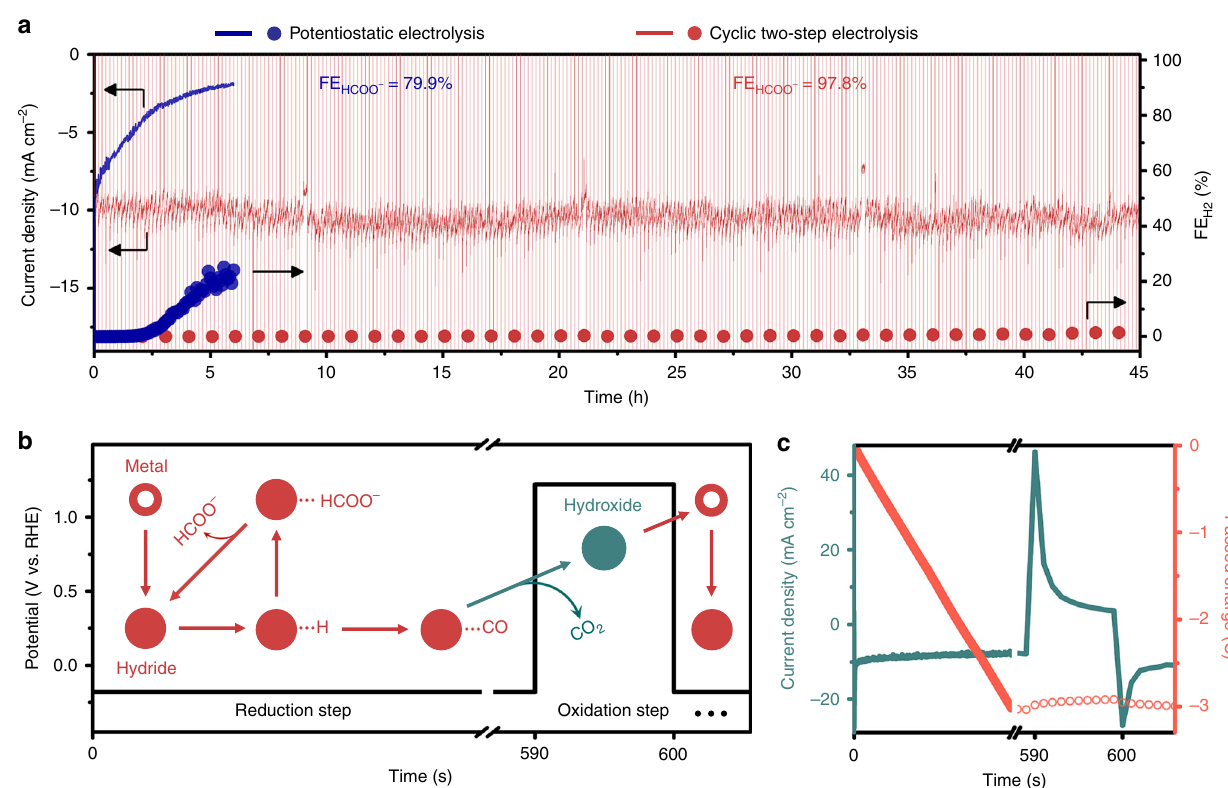
Fig. 3 HCOO − production performance of cyclic two-step electrolysis. a Comparison between cyclic two-step electrolysis and potentiostatic electrolysis in terms of the current density and product selectivity. The blue and red lines represent the current density vs. time curves measured via potentiostatic electrolysis and cyclic two-step electrolysis, respectively. The blue and red circles represent H 2 production selectivity. Both experiments were conducted in a fl ow cell system where CO 2 -saturated bicarbonate solution was continuously refreshed using a peristaltic pump. b Potential program and reaction scheme of the cyclic two-step electrolysis. In the reduction step, − 0.18 V vs. RHE was applied for 590 s, whereas 1.22 V vs. RHE was applied for 10 s in the oxidation step. c Current density vs. time curves and net passed charges during cyclic two-step electrolysis. The charge used in the oxidation step accounts for 3.7% of the charge passed in the reduction